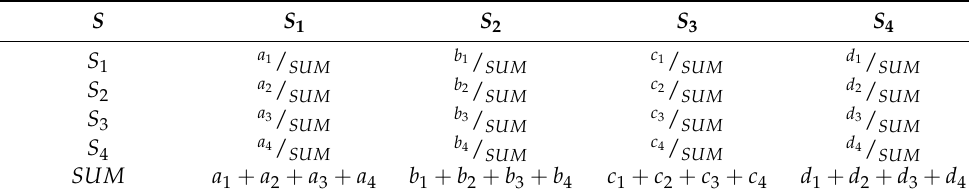
Table 4. Normalized judgment matrix A (cid:48) .